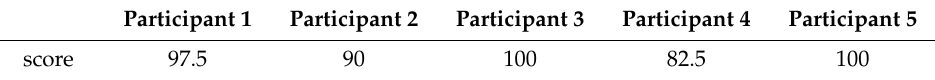
Table 2. System Usability Scale (SUS) questionnaire results for Prototype A .